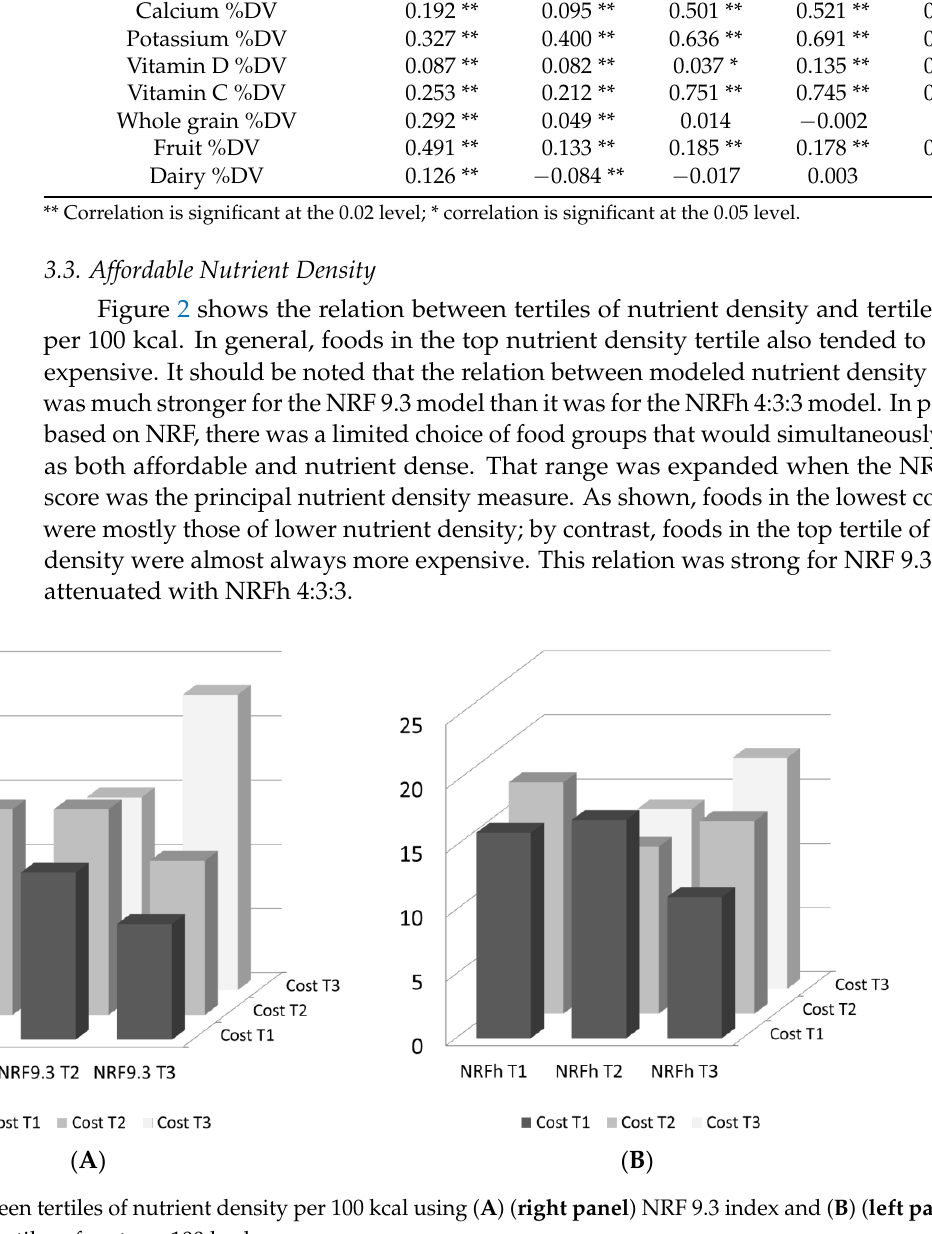
Table 3. Correlations between NRFh 4:3:3 and NRF n.3 energy density, and food components ex- pressed as %DV.